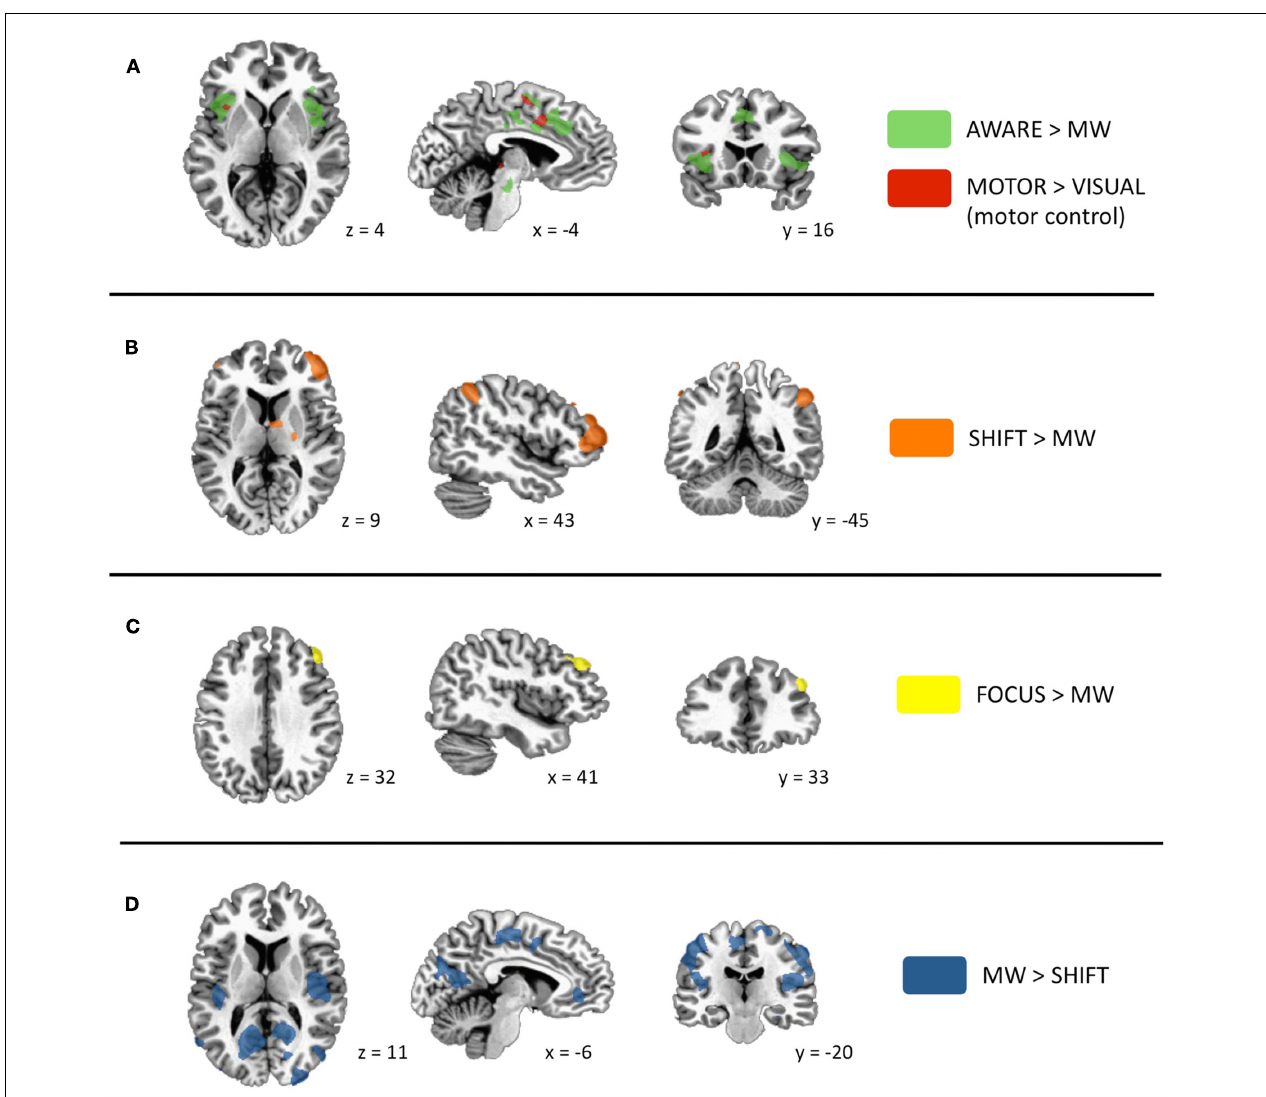
and frontoinsular cortex. (B) Activations in lateral PFC and posterior parietal regions during the SHIFT phase. (C) Activation in dorsolateral PFC during the FOCUS phase. (D) Activations during MW phase included elements of the default mode network, as well as sensory and motor cortices and posterior insula.This figure was adapted from a previous publication (Hasenkamp et al.,